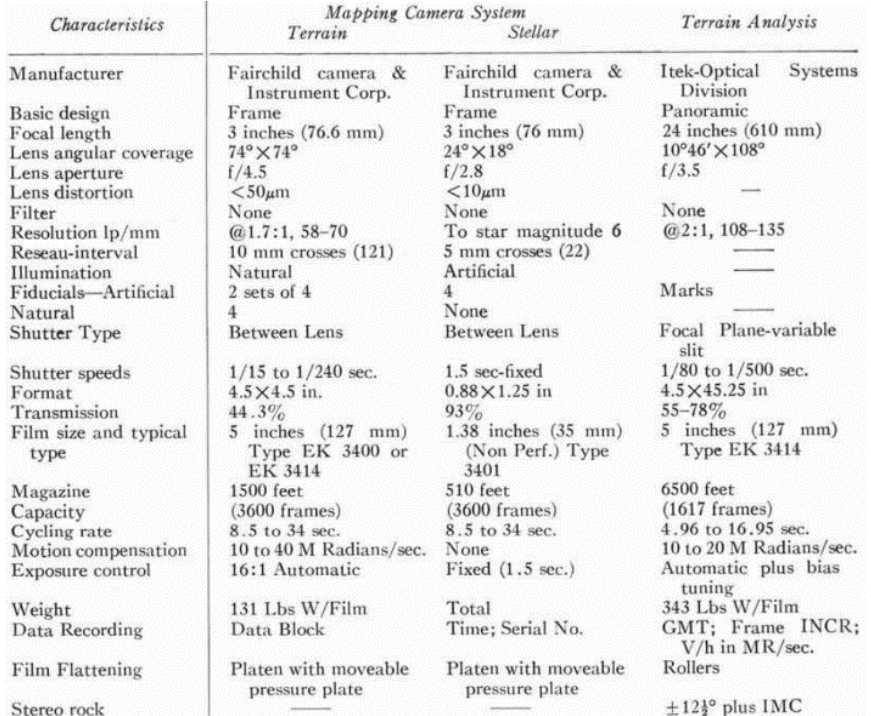
Table 1: Apollo camera characteristics (from Light,